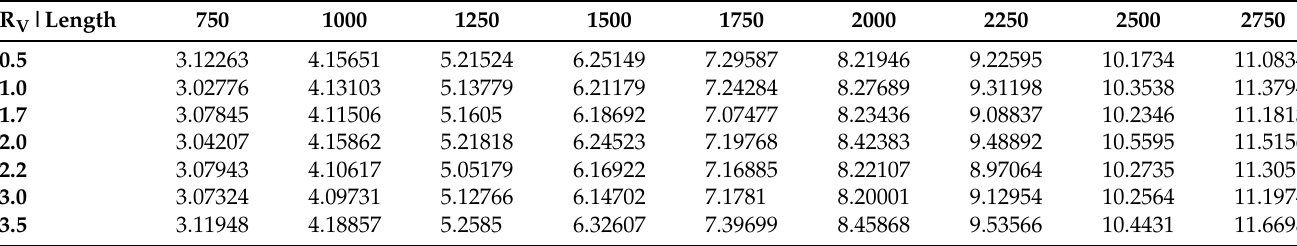
Table A7. Execution times in milliseconds on CPU with cable structure for 30,000 time-steps (1.5 s); R V on the Left and number of cells (length) on the Top .